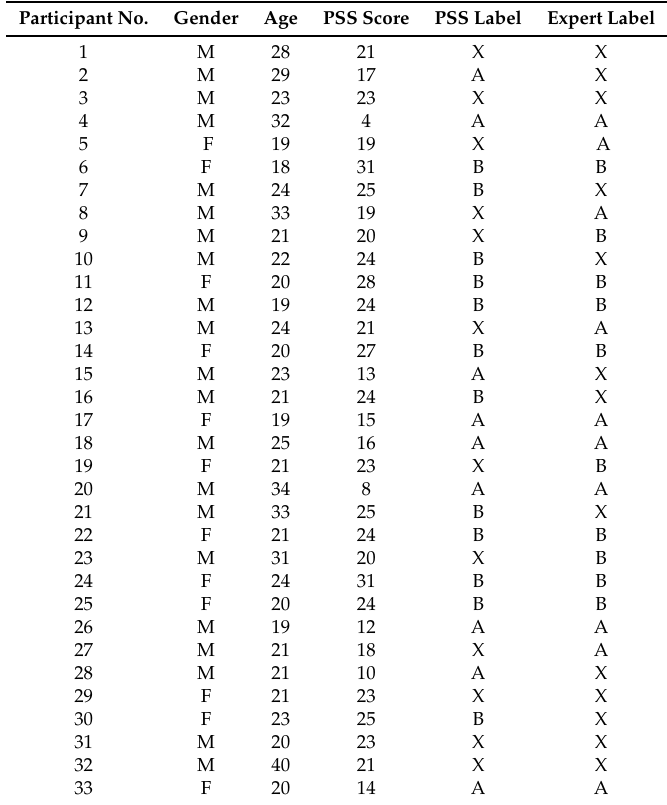
Table 2. Gender, age, PSS score, and labels for the participants according to PSS and expert-based (hybrid) labeling (A-control group, B-stress group, X-neutral). Participant No. Gender Age PSS Score PSS